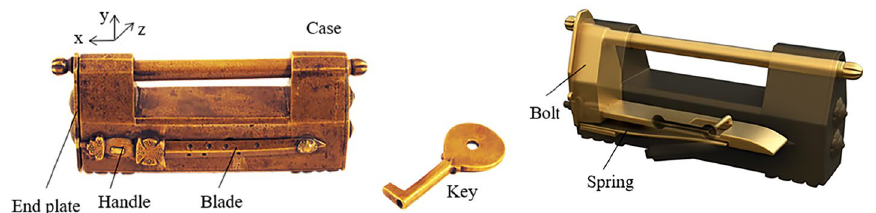
Figure 6. Sliding end-plate lock.